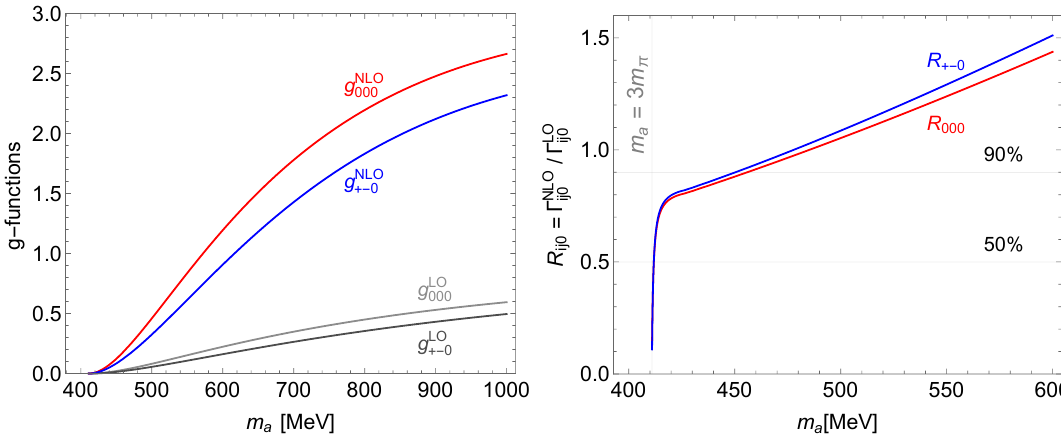
Figure 2 . Left panel: numerical profile of g NLO and g NLO , in red and blue respectively, compared 000 + − 0 to their LO counterparts in light and dark grey. Right panel: ratio of the NLO to LO rates for the two possible decay channels. The vertical grey line indicates the kinematical threshold for the a → πππ decay, with m π = 137 MeV corresponding to the average neutral/charged pion mass (at leading order in the isospin